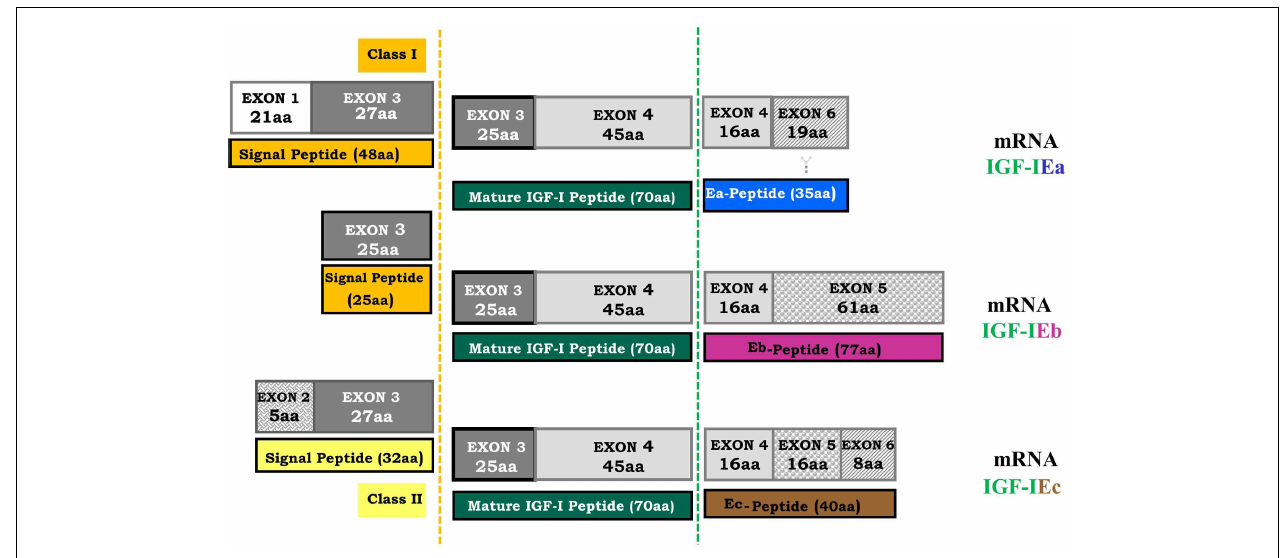
cleavage sites).The different E-peptides are encoded by three mRNA variants produced by alternative splicing of the 3 (cid:48) end of the pre-IGF-I mRNA.The first 16 amino acids of the amino-terminal portion of the IGF-I E-peptides are coded by exon 4. Exons 5 and 6 encode, by alternative splicing, distinct portions of the E-peptides with alternative carboxy-terminal sequences. An N-linked glycosylation site, contained only in the Ea-peptide, is also represented (